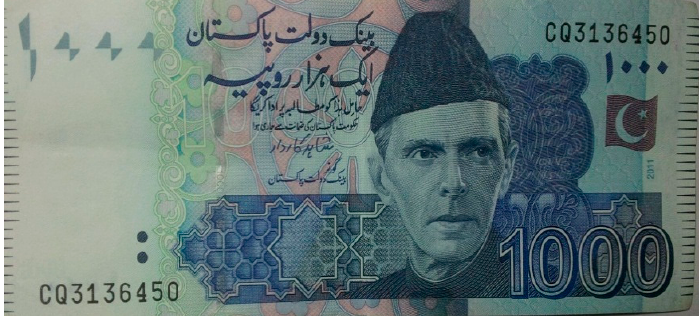
Figure 8. Cropped image of banknote.